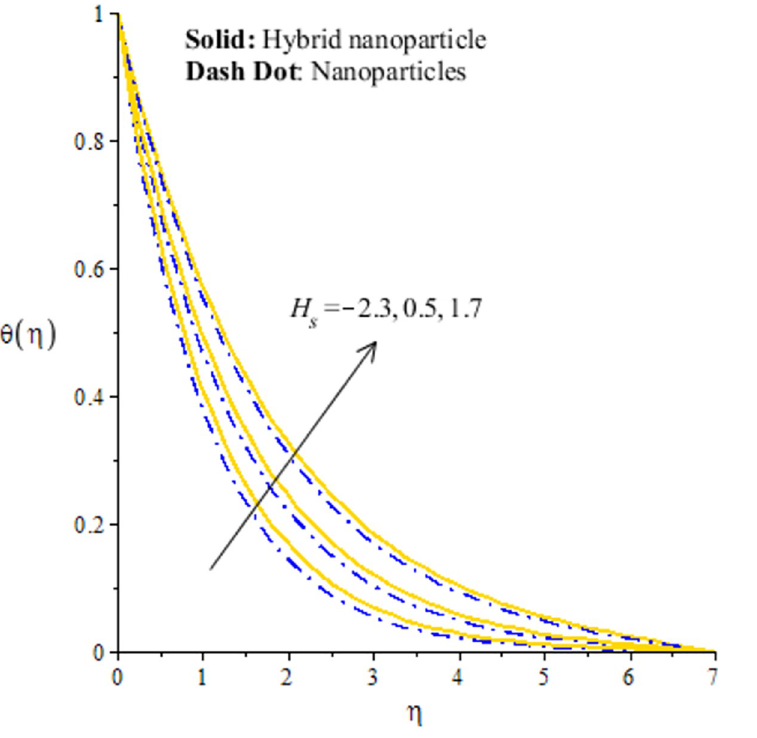
Fig 9. Distribution of temperature versus H